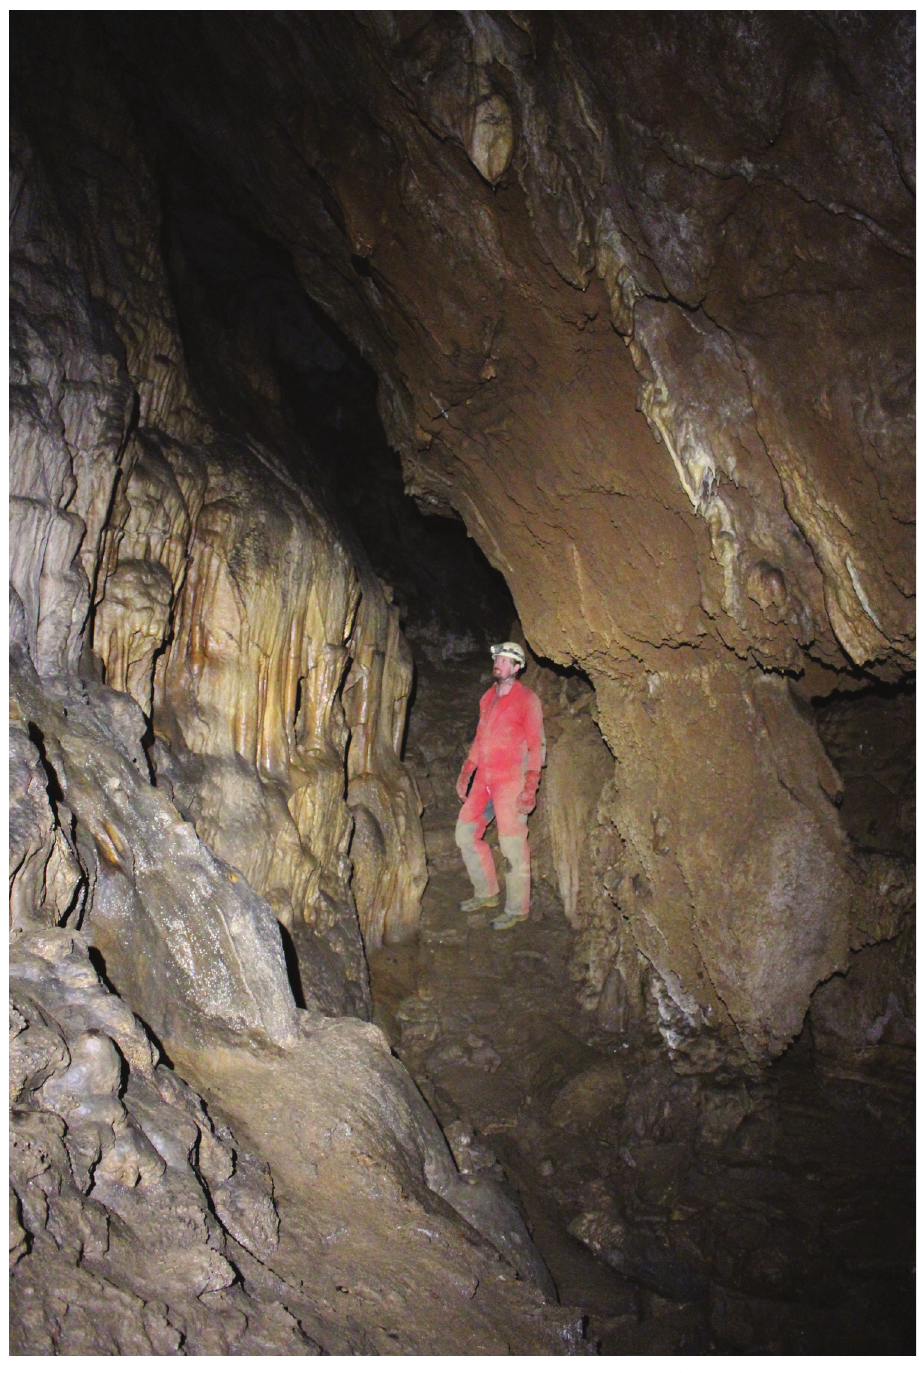
Figure 4. Back part of Hačavská cave, a new locality for the occurrence of N. slovacum in the Slovak Karst (photograph: V. Papáč); northernmost known locality of a member of the subgenus. Indicated as a yellow star on map (Fig.